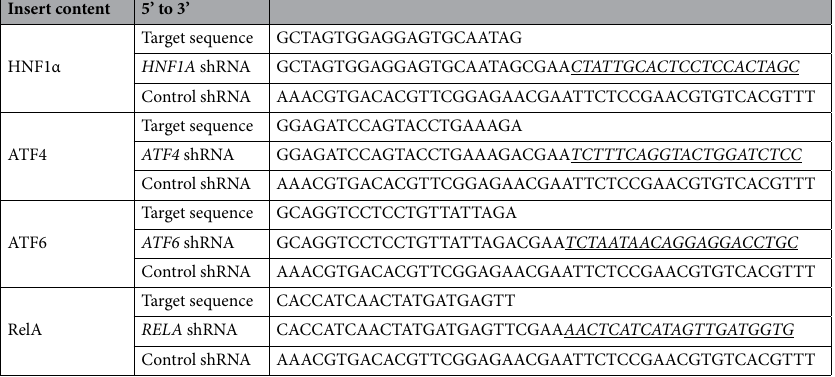
Table 3. shRNA sequences used in LO2